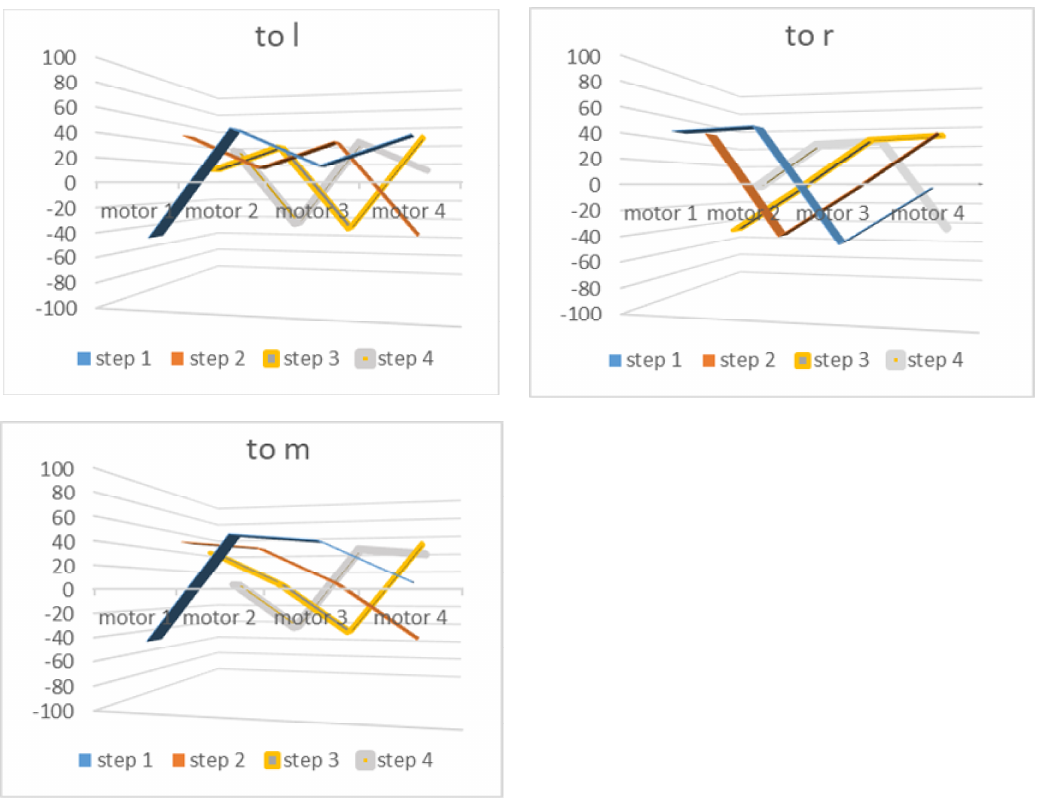
Figure 14. Rotation angles ( y -axis) of different motors ( x -axis) obtained via the ANM system (constrained